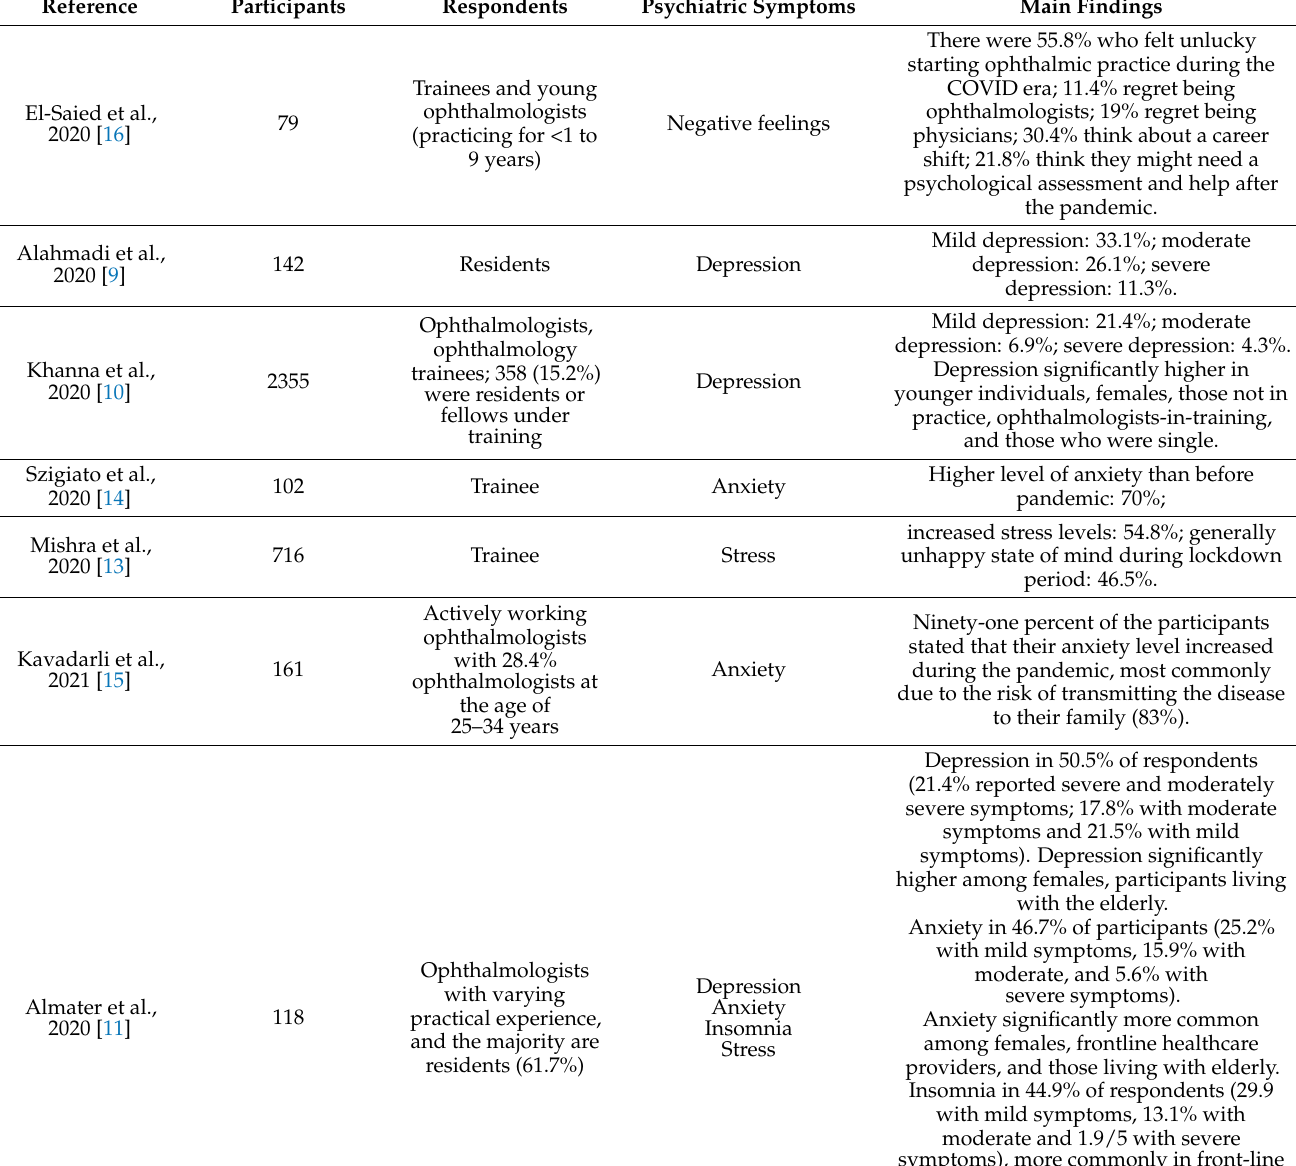
Table 1. Survey studies showing negative impact of COVID-19 pandemic on ophthalmology trainees’ mental